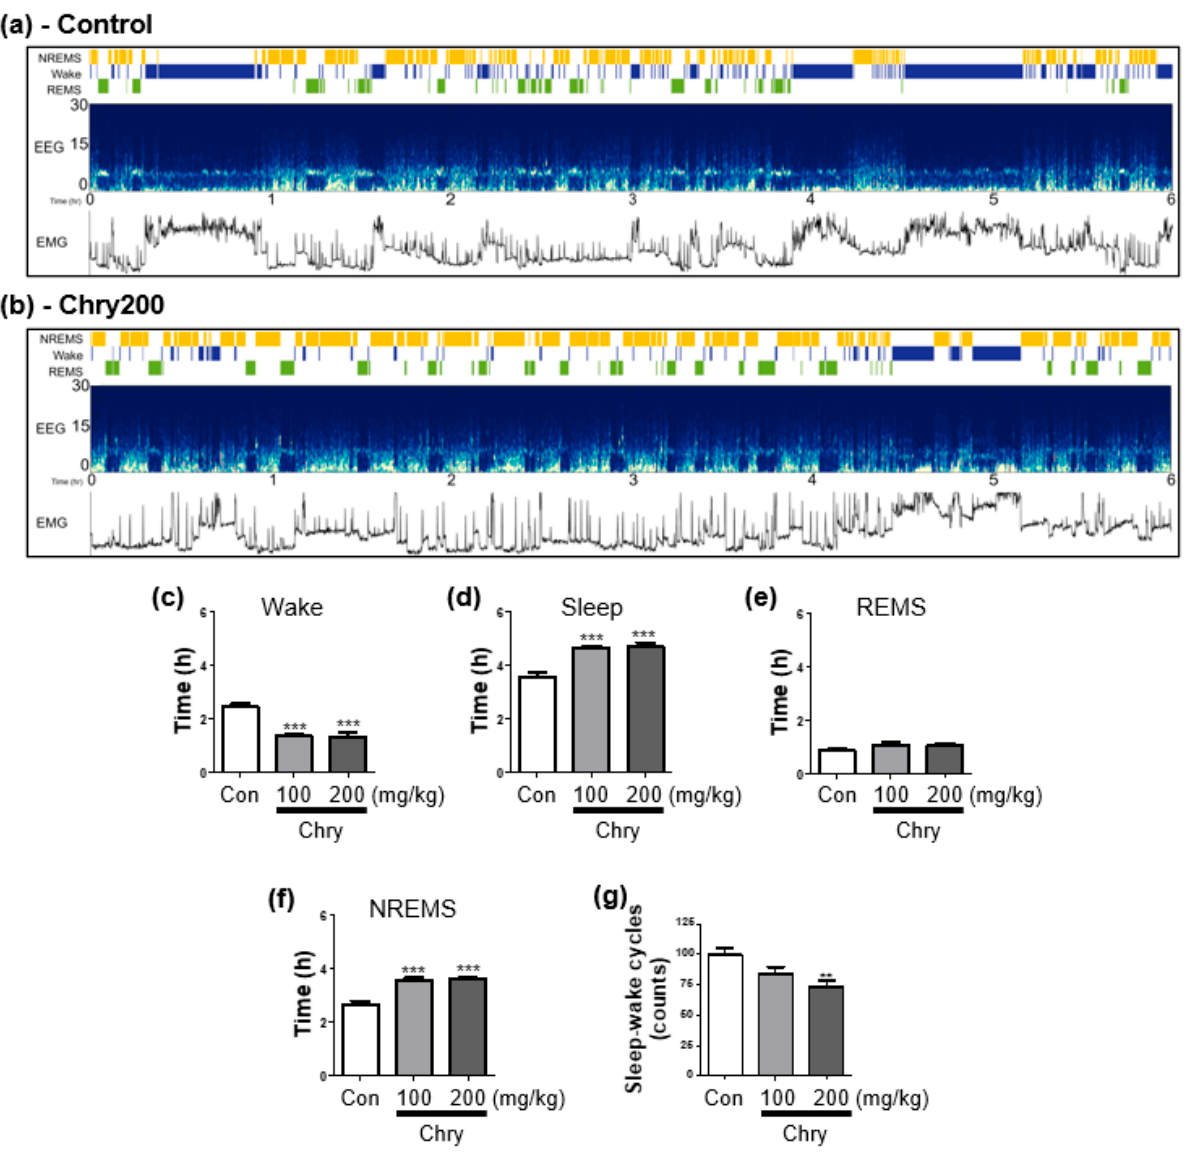
Figure 3. Sleep analysis of rats through automated sleep scoring by AccuSleep algorithm in MATLAB. After the administration of Chry ext (100 and 200 mg/kg, p.o.) once a day for 7 days, EEG and EMG recorded for 6 h (10:00–16:00) at the last administration were used. The representative examples of AccuSleep interface including the sleep stages, EEG spectrogram, and EMG power in control and Chry200 are displayed ( a , b ). Wake and sleep time analysis ( c , d ), duration of REMS and NREMS time ( e , f ), and sleep–wake cycles ( g ) were determined. Data are expressed as mean ± SEM. ** p < 0.01, and *** p < 0.001, compared with the control group. Chry, Chrysanthemum morifolium extract; EEG, electroencephalogram; EMG, electromyogram; REMS, rapid eye movement sleep; NREMS, non-REMS; Wake, wakefulness.